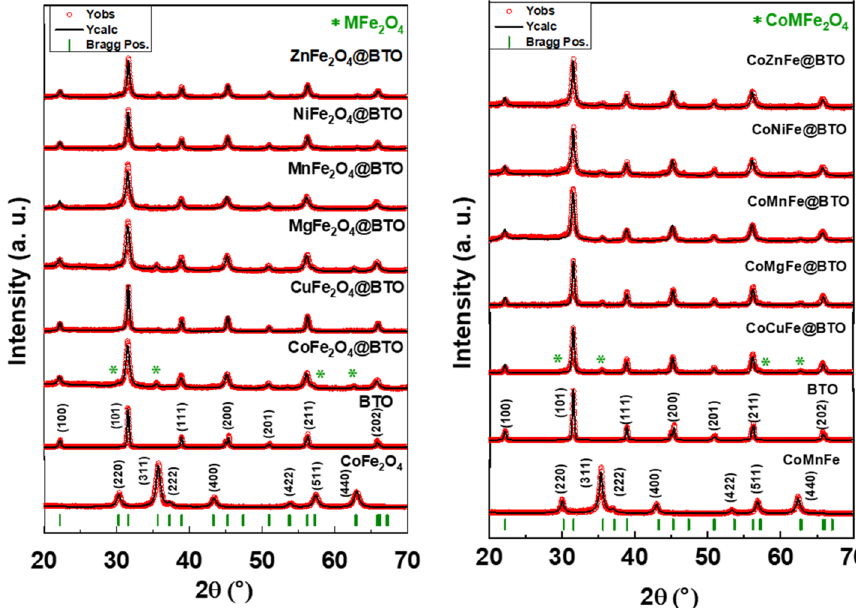
Figure 1. Refined XRD powder patterns of (CoFe 2 O 4 , CoMnFe) MNPs and core–shell (MFe 2 O 4 @BTO, CoMFe@BTO; M = Mn, Ni, Mg, Cu, Zn, or Co) MENCs.